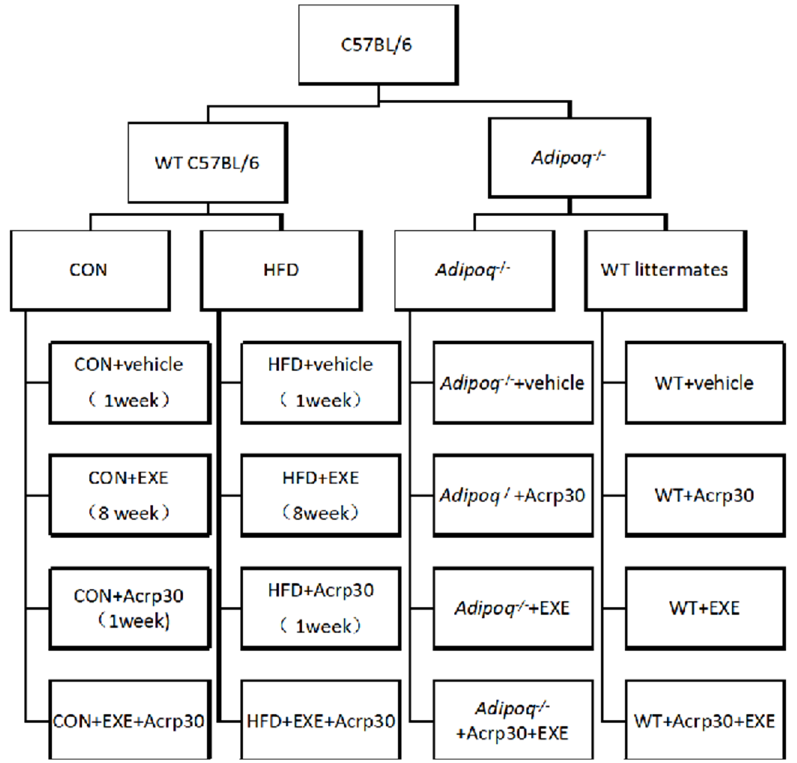
Figure 5. Schemata of the animal experimental set-up. CON, control; EXE, exercise; WT, wild type; Acrp30, adiponectin; HFD, high-fat diet; Adipoq, mouse adiponectin gene; Adipoq-/-, adiponectin gene knockout